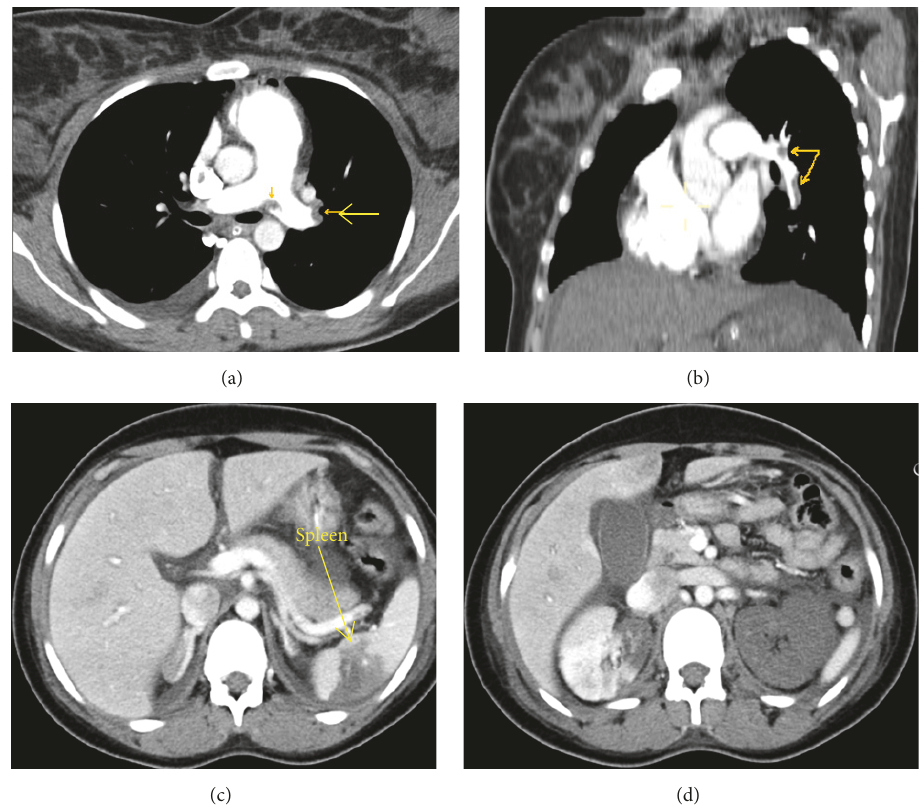
Figure 1: CECT PE Protocol showing bilateral massive pulmonary embolism (yellow arrows). CECT abdomen showing infarction in spleen (c). In (d), partly infarcted right and totally infarcted kidneys are also seen with partial opacification of inferior vena cava (d).